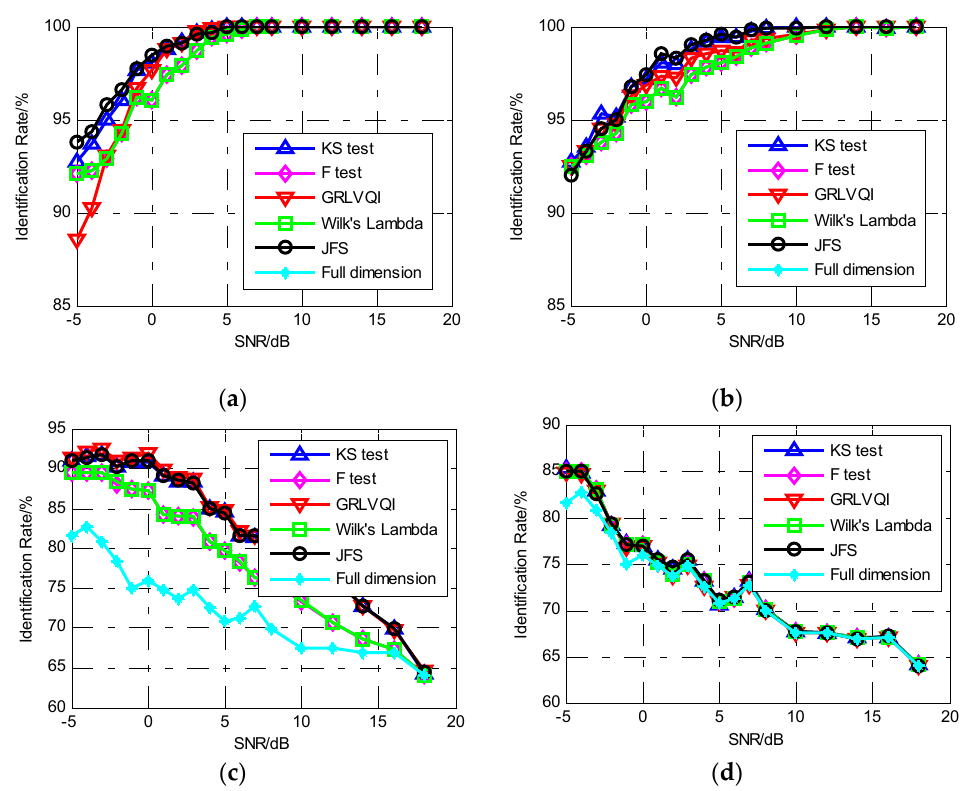
Figure 6. The SVM classification performance for two classes using the IMF-DNA algorithm. ( a ) N d = 10. ( b ) N d = 30. ( c ) N d = 50. ( d ) N d = 80.